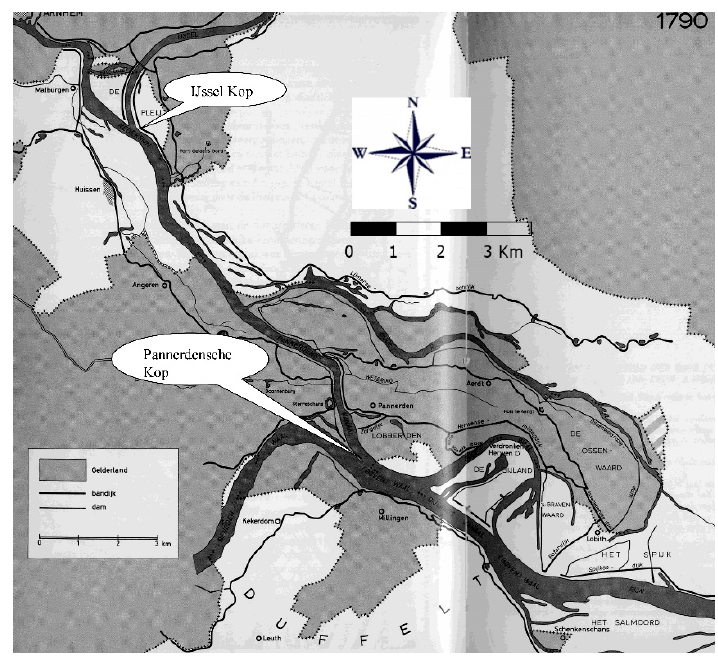
Figure 3. Rhine bifurcations, end of 18th century at Pannerden and Westervoort (copyright [5]).